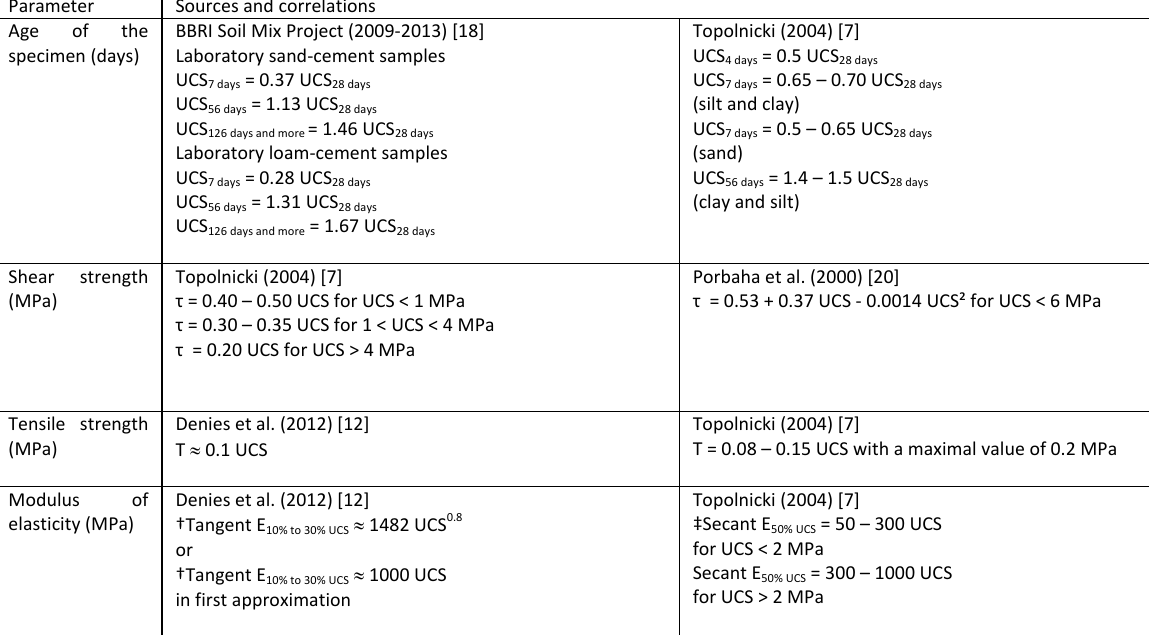
Table 2. Typical correlations that can be used for the first assessment of the properties of the soil mix material used for the construction of retaining walls. Parameter